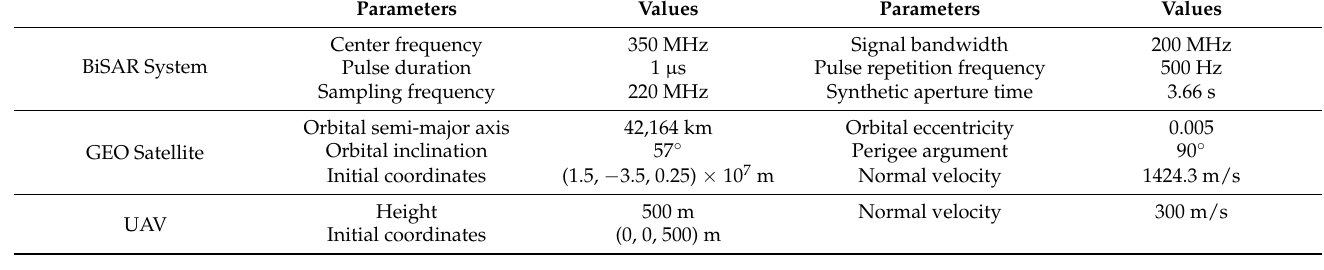
Figure 8. Variation of the speed-up factor. ( a ) With respect to the fusion time M ; ( b ) With respect to the fusion aperture n .